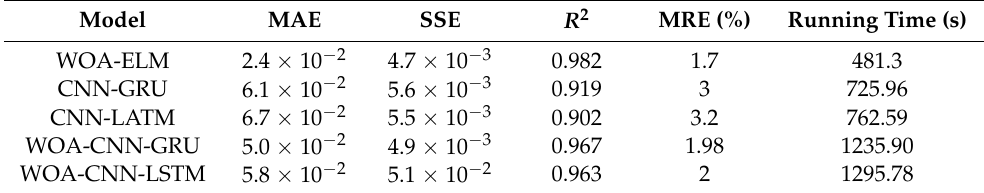
Figure 8. Comparison between predicted results and actual values of each model. Table 14. Comparison table of each parameter of the model.